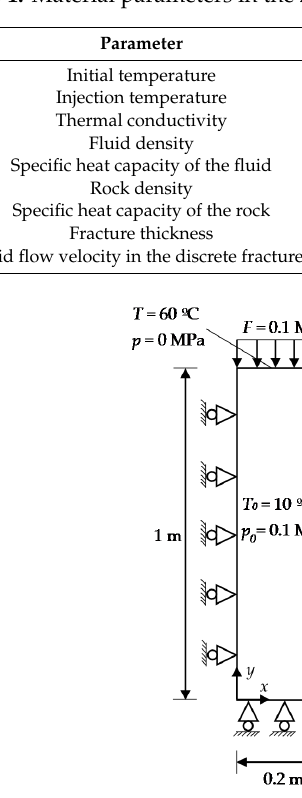
( b ) Figure 11. Comparison of analytical and numerical solution in the soil column at different positions: ( a ) displacement; ( b ) pore pressure.